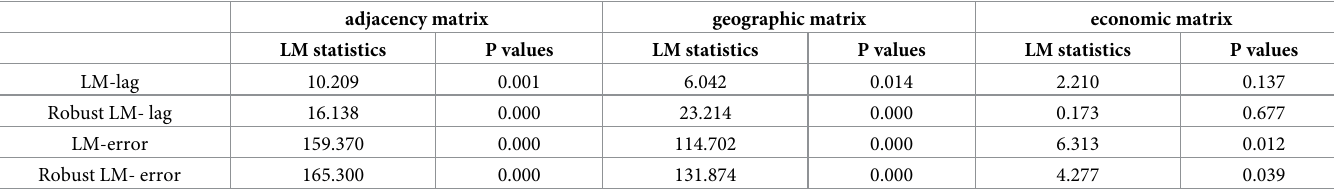
Table 7. LM test for model